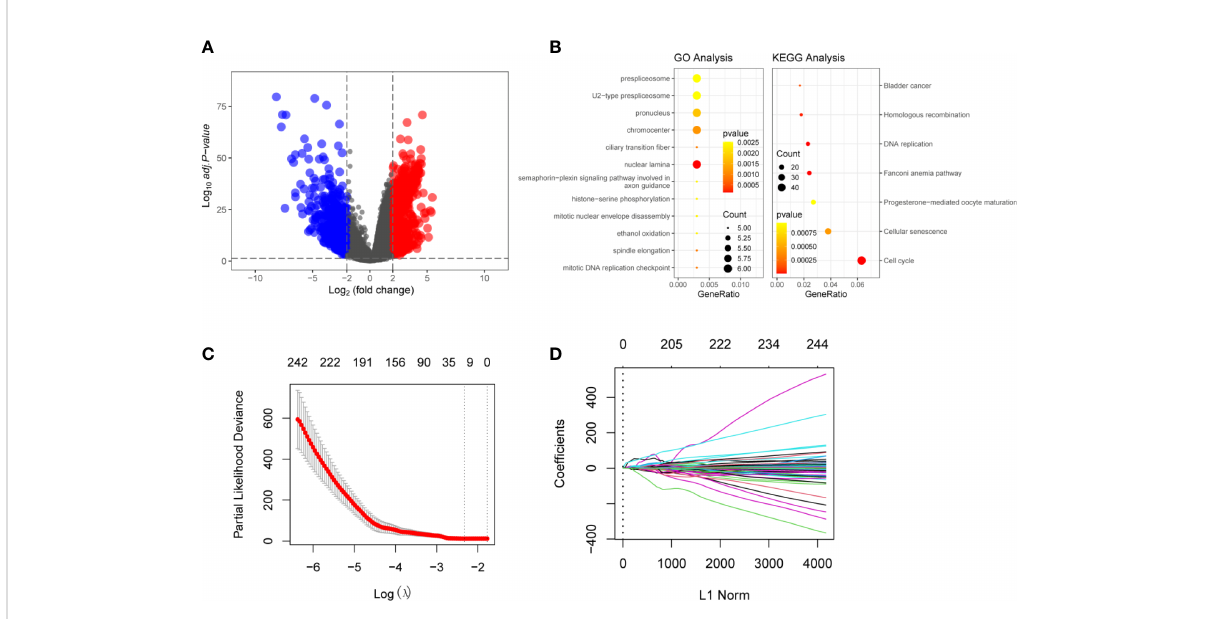
FIGURE 2 Identi fi cation of The Differentially Expressed Genes (DEGs) in HCC and normal liver tissues: (A) Volcano plot of the DEGs in TCGA dataset. Log| FC|>2 was considered as DEGs In the fi gure, red represents high-expression genes, and blue represents low-expression genes (B) Functional analyzing by GO and KEGG. The yellower the color indicates that the result is more meaningful, and the larger the circle, the more genes are enriched within the result. (C) LASSO Cox regression was performed to identify the DEGs related to the prognosis of HCC ( l = 0.08869376). (D) Visulization of LASSO Cox regression. These 13 genes that were DSTNP2, EZH2, GRPEL2, 227 MYCN, NDRG1, PIGU, PPM1G, SF3B4, SQSTM1, TCOF1, TUBG1, TXNRD1, and UCK2 might predict prognosis of